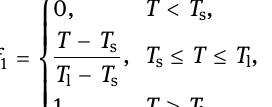
The geometric model is drawn by external three - dimen - sional software and imported into Ansys. The solid186 advanced unit is used to mesh the model, as shown in Figure 4. The nonlinear hexahedral mesh is adopted, with the minimum mesh side length of 0.1 mm and the max - imum mesh side length of 0.8 mm. The total number of units is 43,200, and the number of nodes is 206,236.